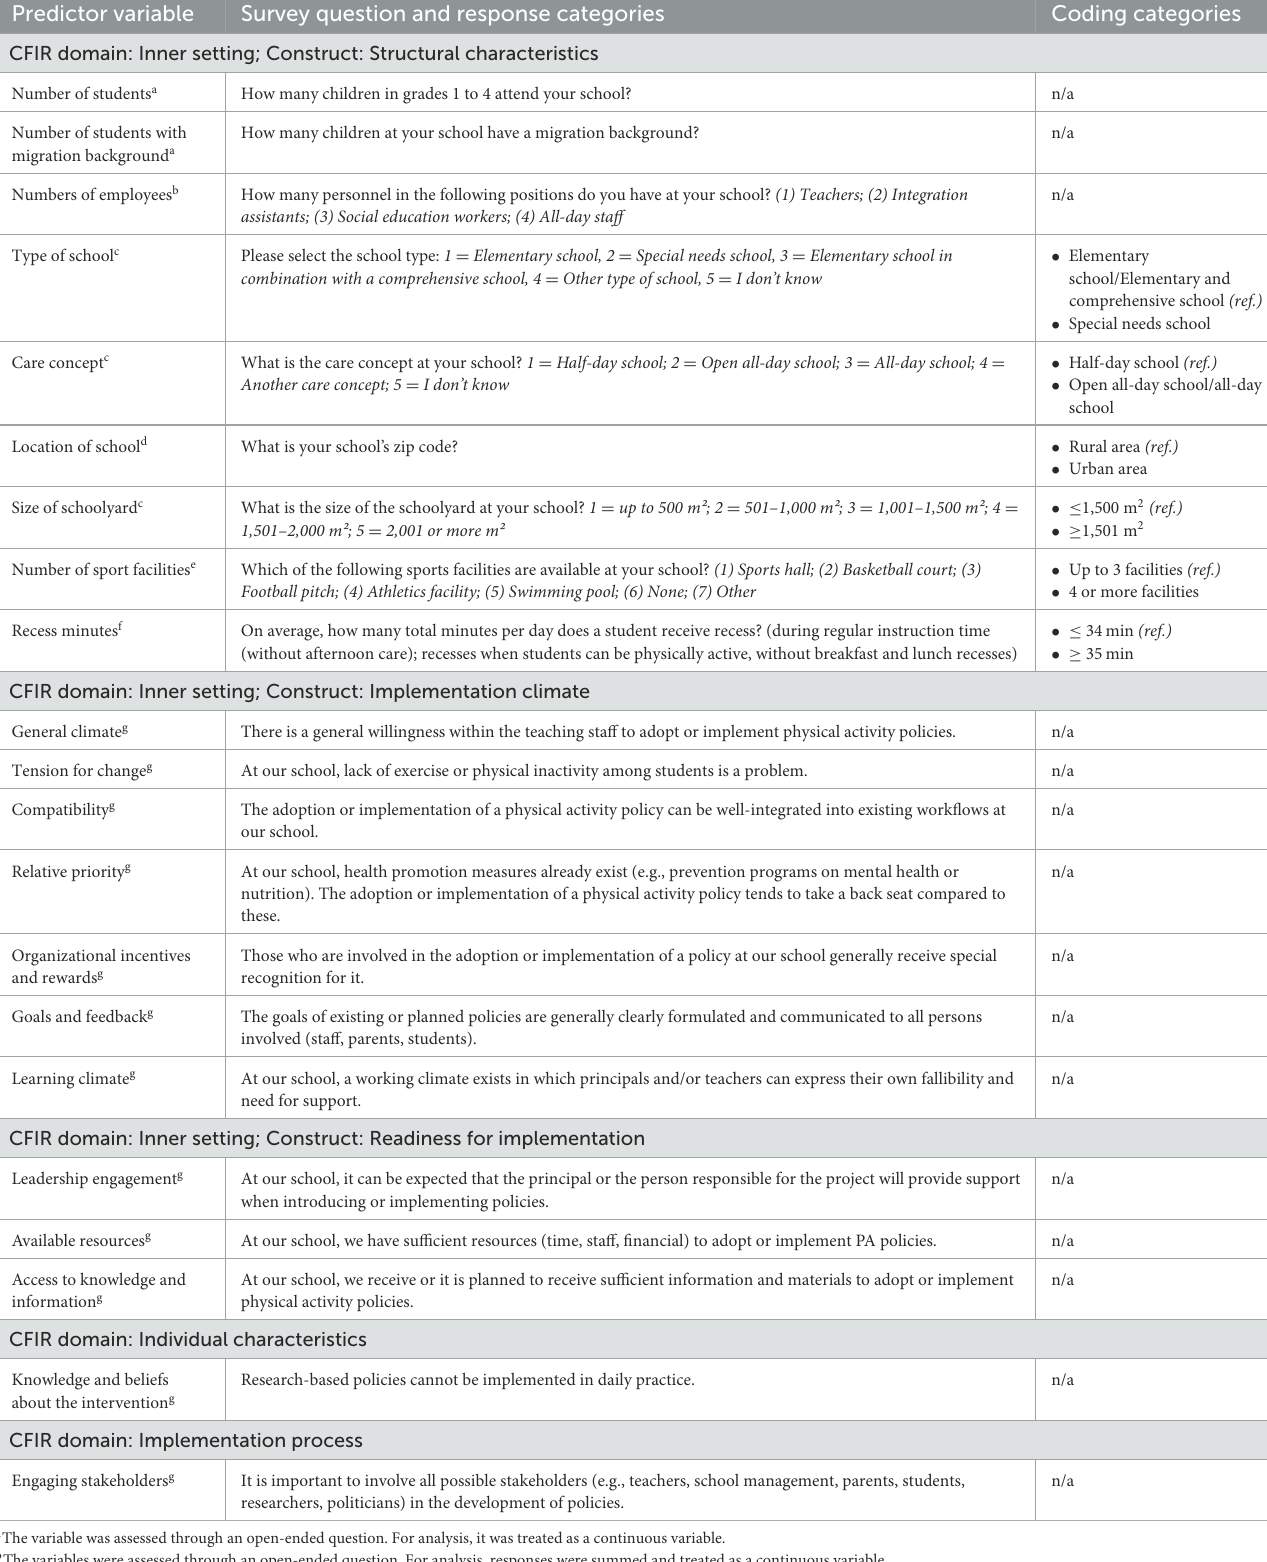
TABLE 1 Description of CFIR predictor